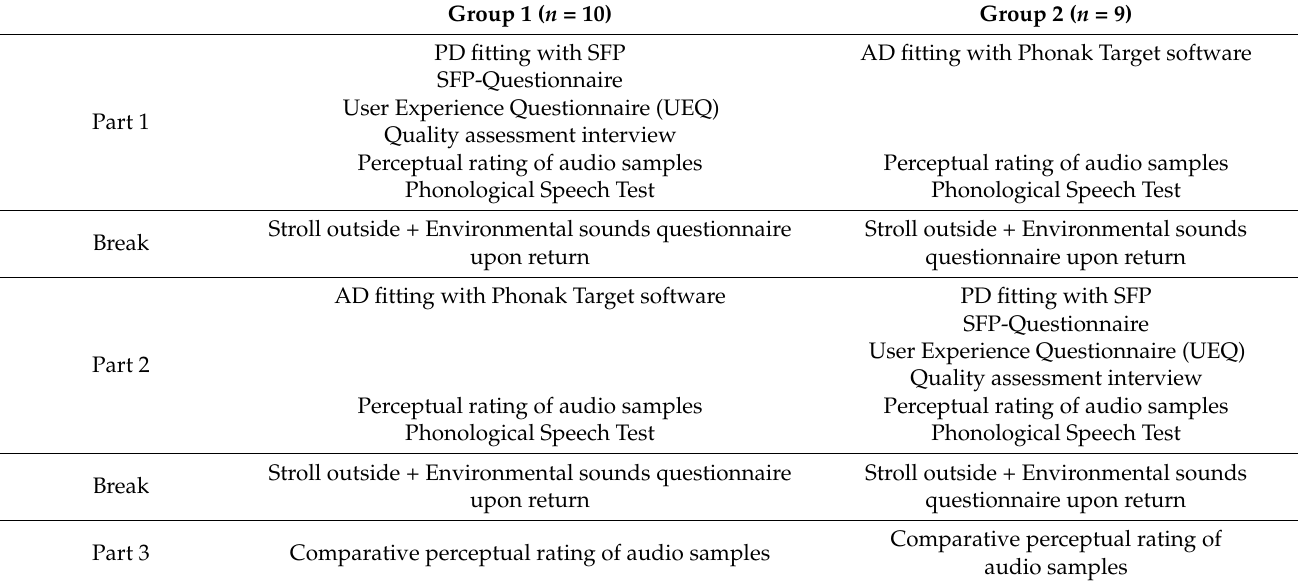
Table 1. The procedure of the first session for each participant group. Group 1 ( n =